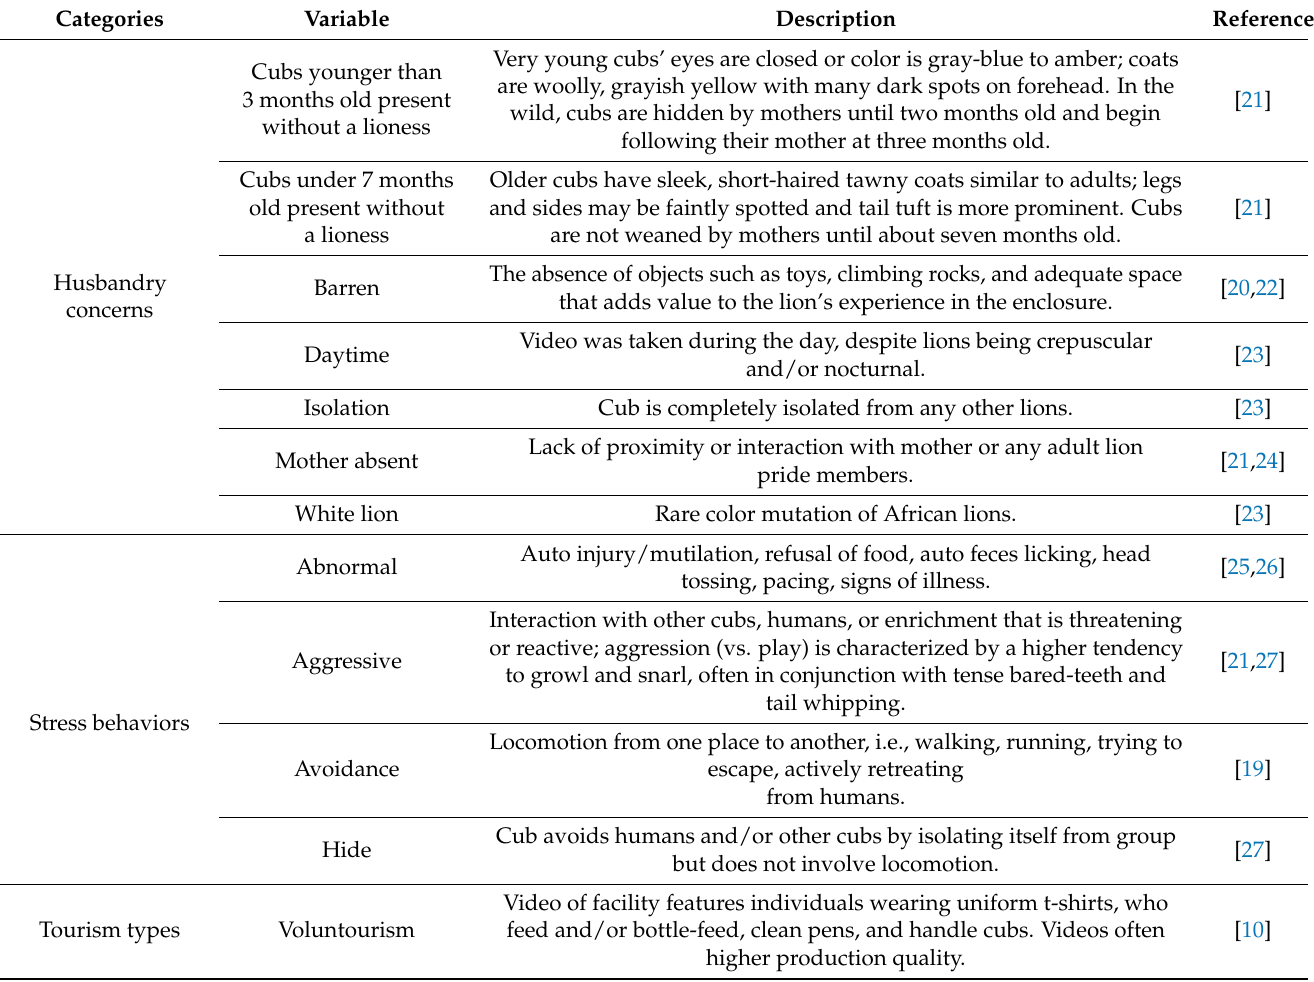
Table 1. Behaviors and conditions; descriptions of lion cubs